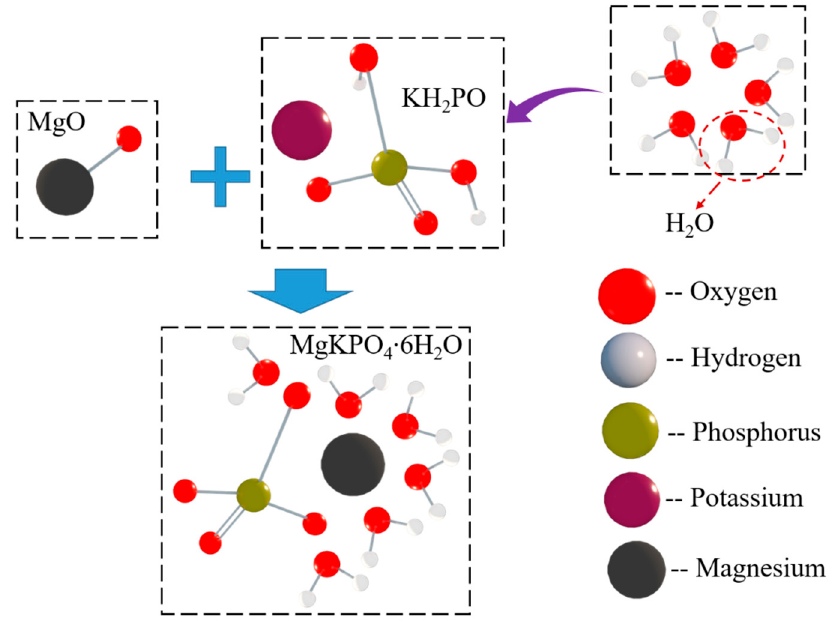
Figure 15. Hydration process of MPC.